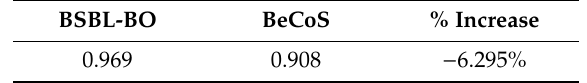
Table 4. Comparison of BSBL-BO and BeCoS complex-wavelet structural similarity (CW-SSIM). BSBL-BO